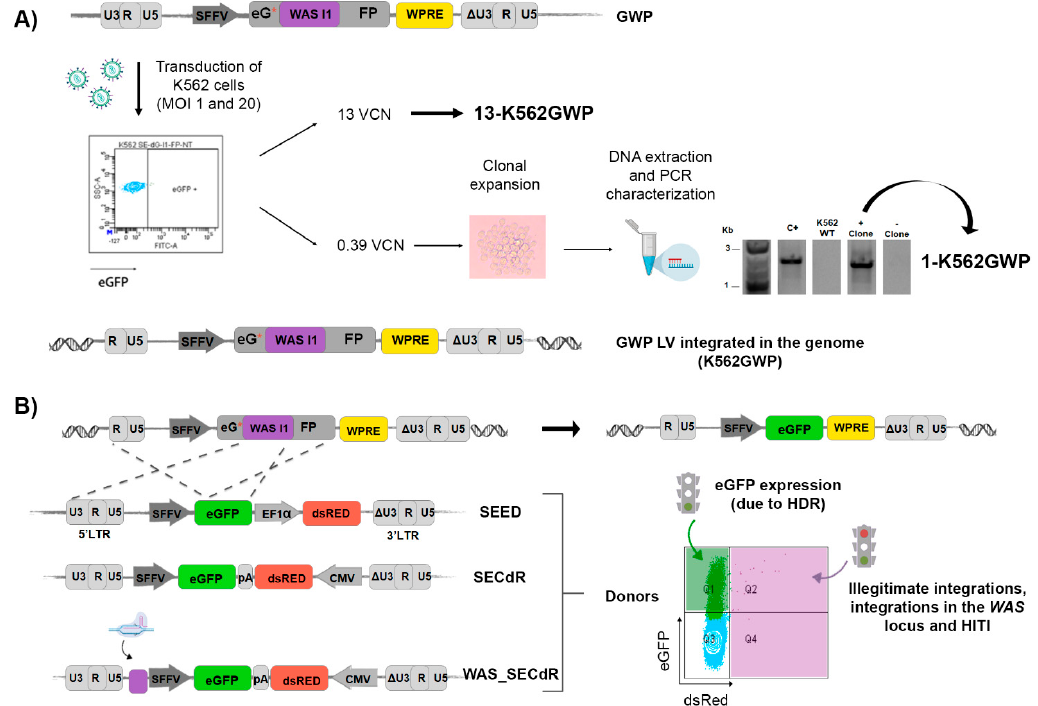
Figure 3. Development of K562GWP reporter cell lines (eGFP-ON / dsRED-OFF). ( A ) Scheme showing the procedure to generation of the K562GWP reporter cell lines. Top: Representative scheme of